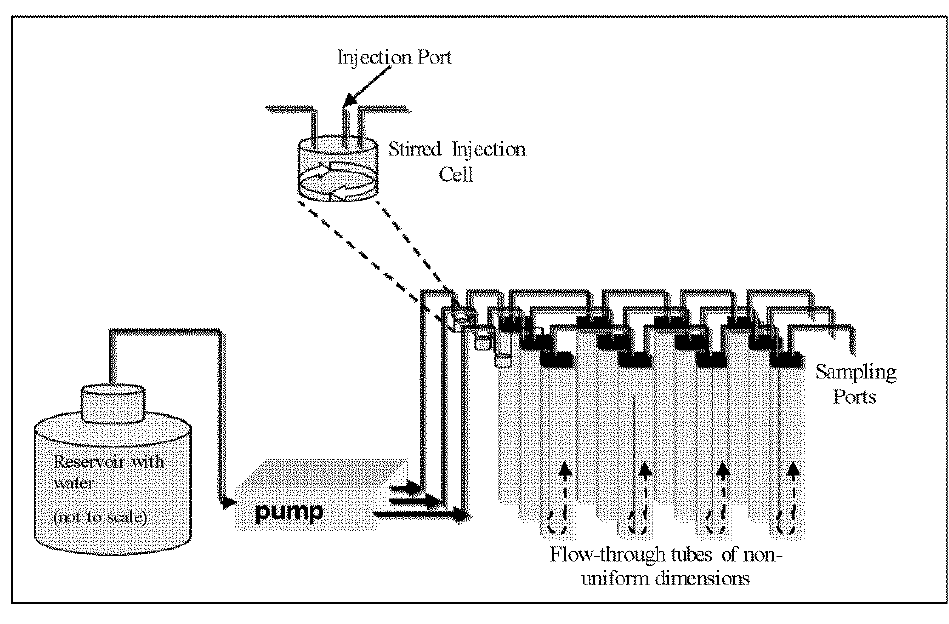
Figure 2. Dye study